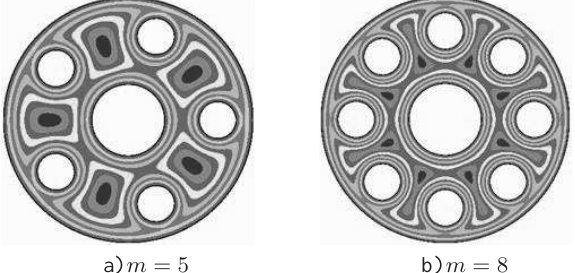
Figure 3. Contour lines of functions (3.5) for r 0 = 5 , r 1 = 1 , r 2 = 2 , r 3 = 7